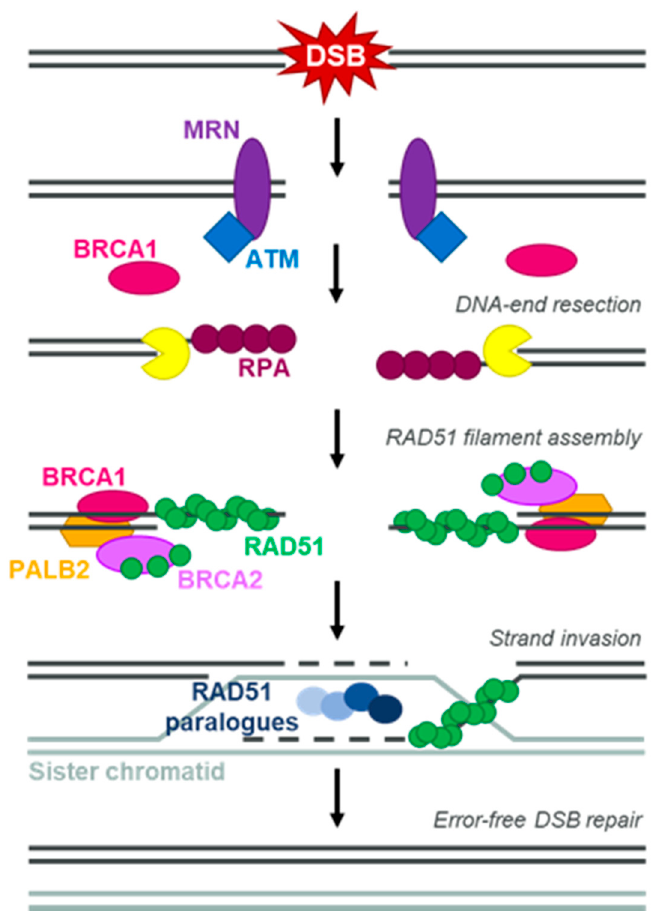
Figure 1. Homologous recombination repair. Simplified schematic of homologous recombination repair (HRR) of a DNA double-strand break (DSB) using the sister chromatid as repair template. Key proteins involved are highlighted in the figure.